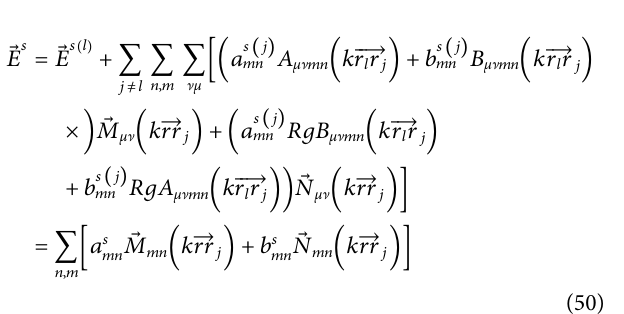
FIGURE 1 | The in fl uence of surface charge density on the scattering/extinction cross sections of a single particle. Surface charge densities are set to η (cid:1) 1 , 10 , 100 , ∞ mC/m 2 . (A) the ratioof scattering crosssection ofa charged particleto thatof an uncharged one. C s ofachargedparticleandanunchargedone. (B) Theratioofextinctioncrosssectionofachargedparticletothatofanunchargedone. C ext and C 0 ext denotetheextinction cross section of charged and uncharged